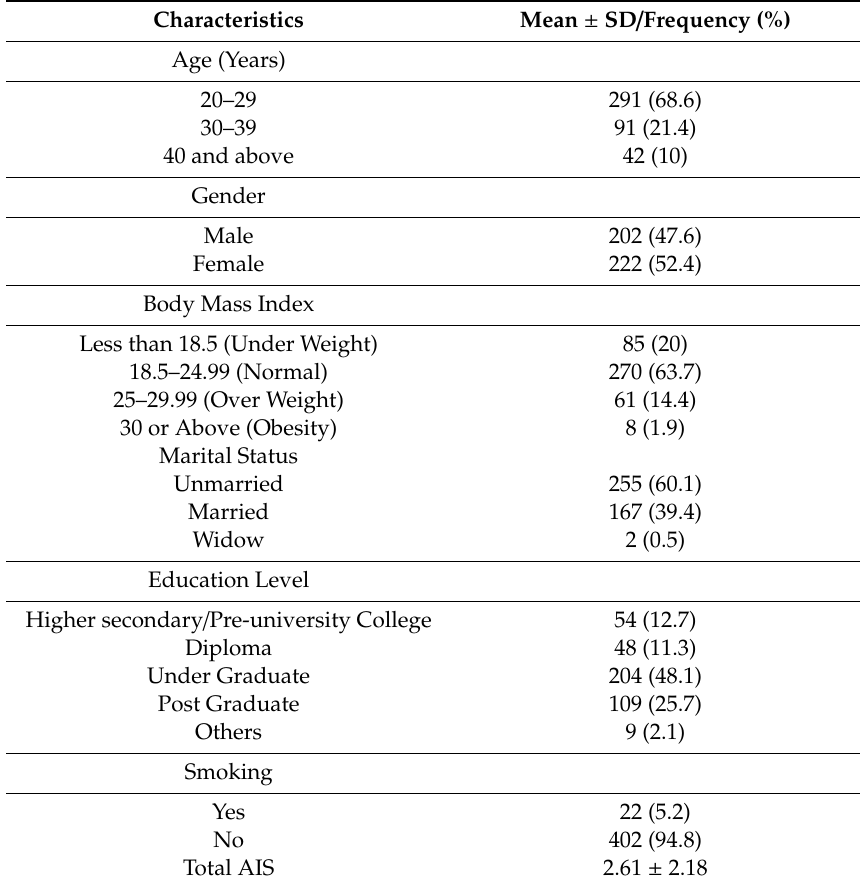
Table 1. Participant